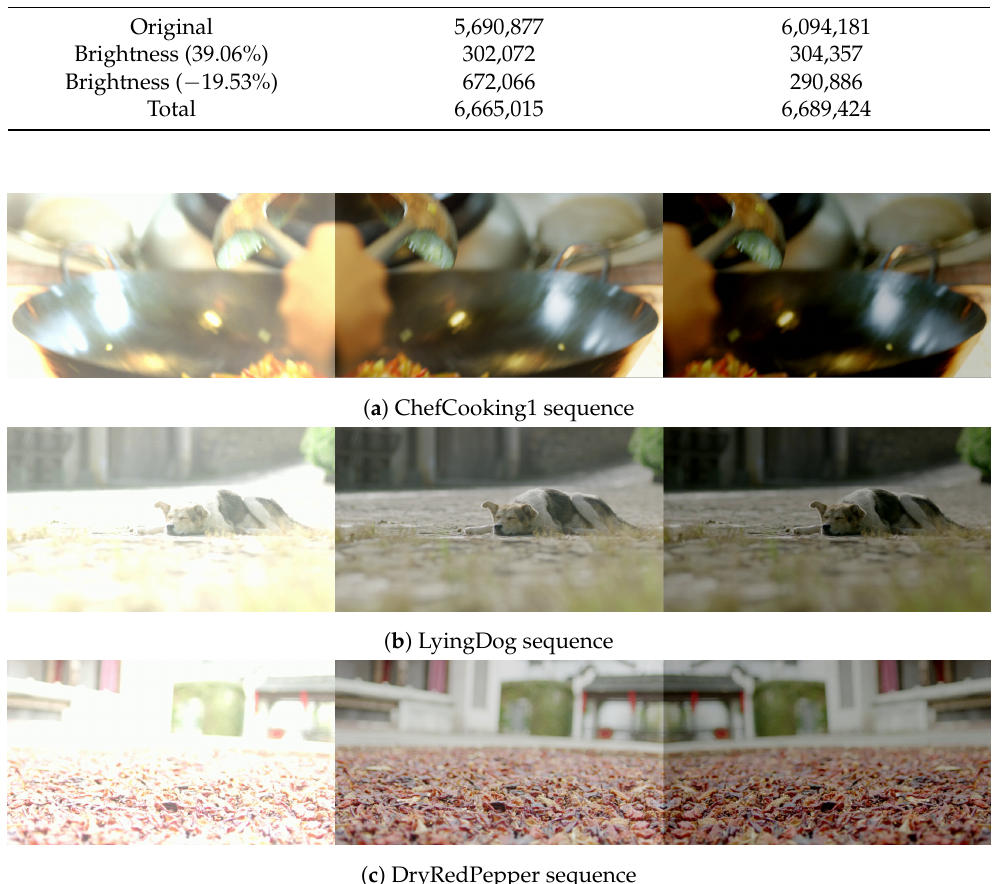
Figure 3. Examples of TVD sequences after data augmentation: a lightened image ( left ), the original image ( center ), and a darkened image ( right